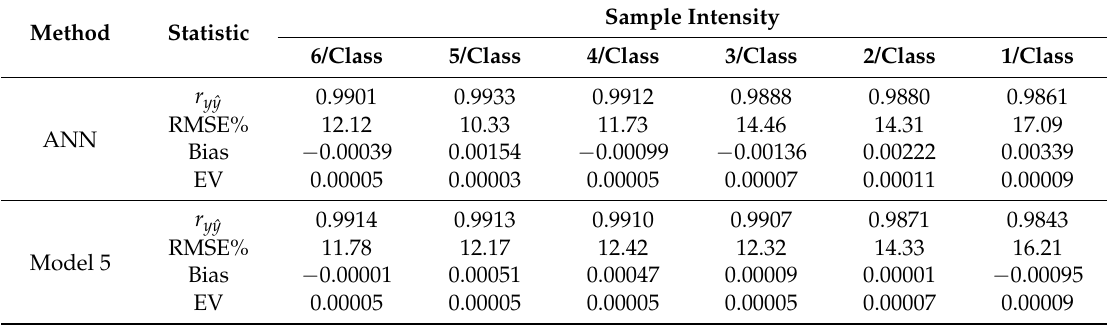
the artificial neural networks, and equations for Model 5 in the sample intensities of scenario